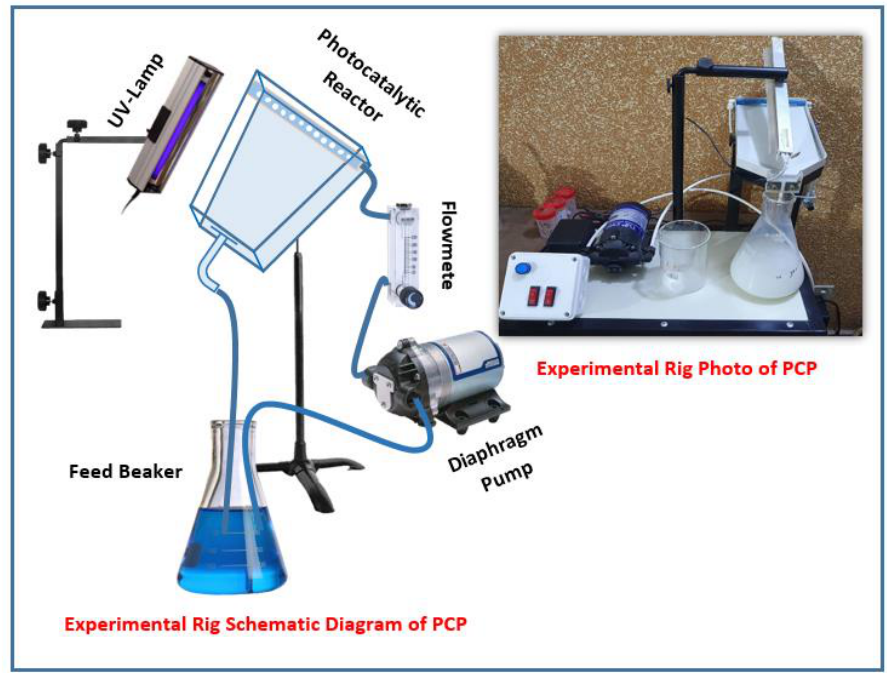
Figure 14. The experimental device used in the photocatalytic process (photo and